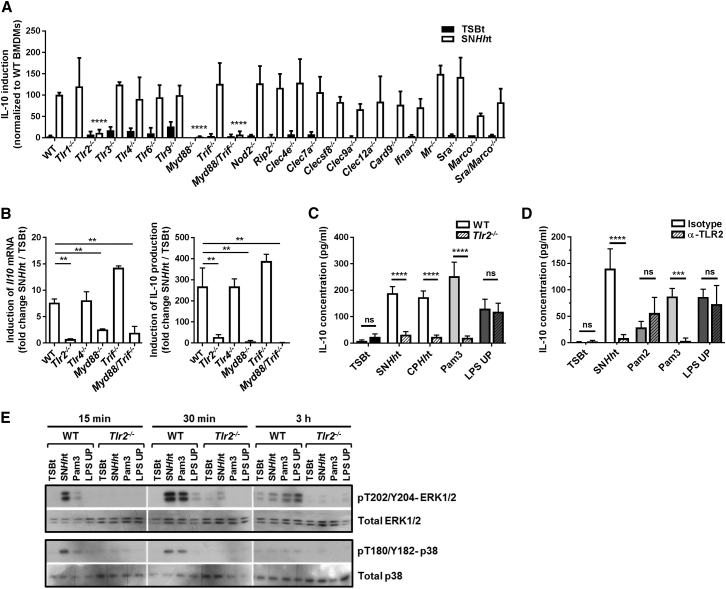
SNHht Signals through TLR2 and MyD88 to Induce IL-10(A) Induction of IL-10 production in different knockout C57BL/6 BMDMs stimulated for 3 hr with SNHht normalized to WT BMDMs (three independent experiments). Two-way ANOVA and Bonferroni’s multiple comparisons test, p < 0.05. Ifnar, interferon-a/b receptor; Mr, mannose receptor; Sra, scavenger receptor A.(B) Il10 mRNA and protein induction in different knockout BMDMs stimulated for 3 hr with SNHht (one of three independent experiments). One-way ANOVA and Tukey’s multiple comparisons test, p < 0.05.(C) Induction of IL-10 production in WT and Tlr2−/− BMDMs stimulated for 3 hr with TSBt, SNHht, CPHht (SNHht crude polysaccharide fraction), LPS UP (TLR4 ligand), or Pam3 (TLR2/1) (one of three independent experiments). Two-way ANOVA and Sidak’s multiple comparisons test, p < 0.05.(D) Induction of IL-10 production in WT BMDMs pre-treated for 2 hr with a blocking antibody specifically inhibiting TLR2 signaling (monoclonal α-mTLR2-IgG) or its isotype control before stimulation for 3 hr with TSBt, SNHht, Pam2 (TLR2/6), Pam3, or LPS UP (three independent experiments). Two-way ANOVA and Sidak’s multiple comparisons test, p < 0.05.(E) Western blot showing the phosphorylation of ERK1/2 and p38 and the total ERK1/2 and p38 protein amounts in WT and Tlr2−/− BMDMs after stimulation with TSBt, SNHht, Pam3, or LPS UP for 15 min, 30 min, and 3 hr. Mean ± SD. See also Figure S4.